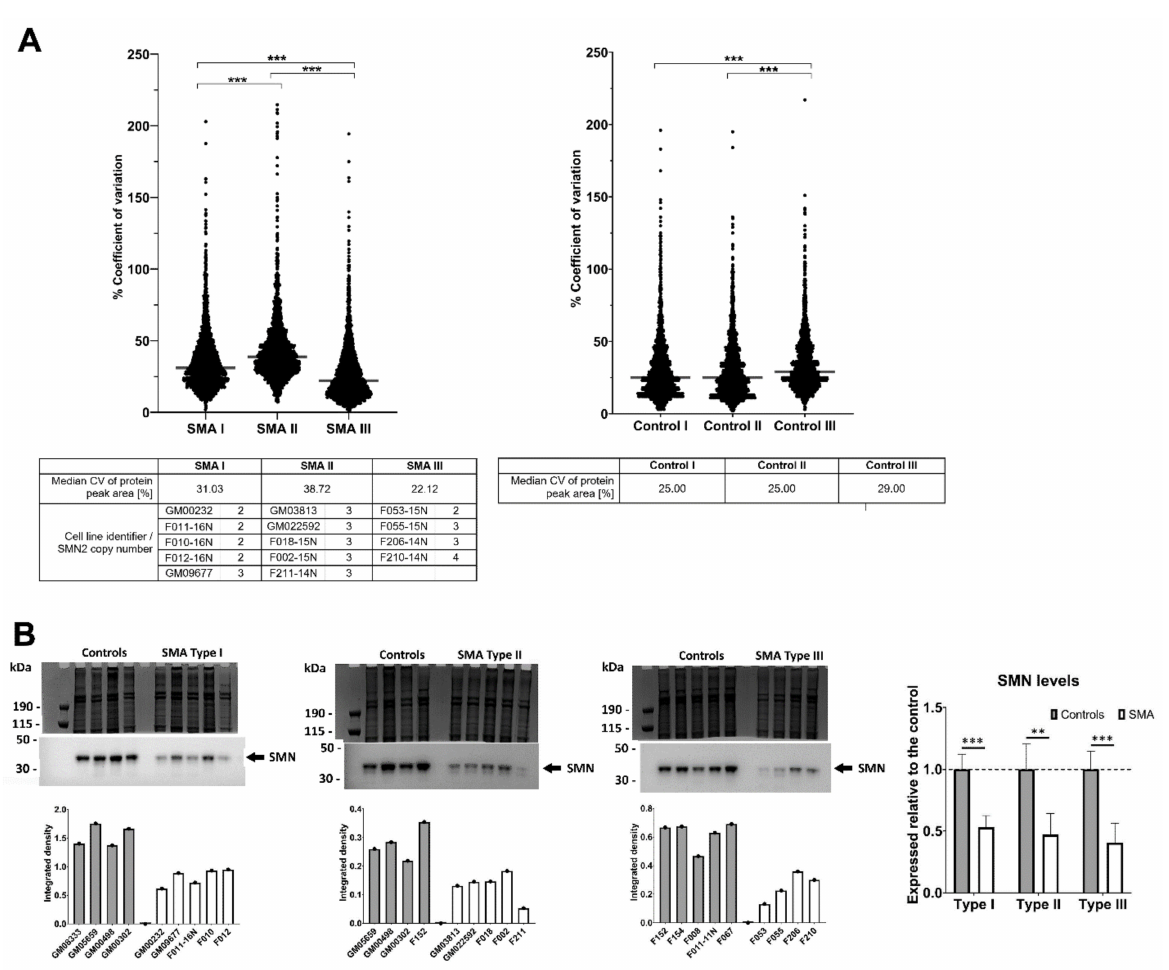
Figure 1. Variability in protein expression and levels of SMN protein in SMA Types I, II and III fibroblasts and respective age-matched controls. ( A ) Summary of the coefficients of variation for